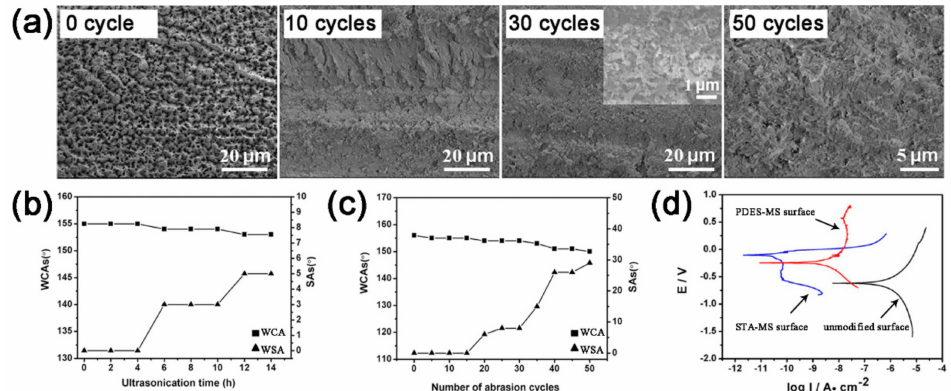
Figure 5. Mechanical stability and corrosion resistance evaluation of the PDES-MS surface: ( a ) Surface morphologies of the PDES-MS surface before and after abrasion test for 10, 30, and 50 cycles with sandpaper; ( b ) The variations of WCAs and WSAs under di ff erent ultrasonication time; ( c ) Variations of WCAs and WSAs of the PDES-MS surface after abrasion tests; ( d ) Potentiodynamic polarization curves of the unmodified and modified surfaces in 3.5 wt % NaCl solution. Reprinted with permission from [67]. Copyright (2014) American Chemical